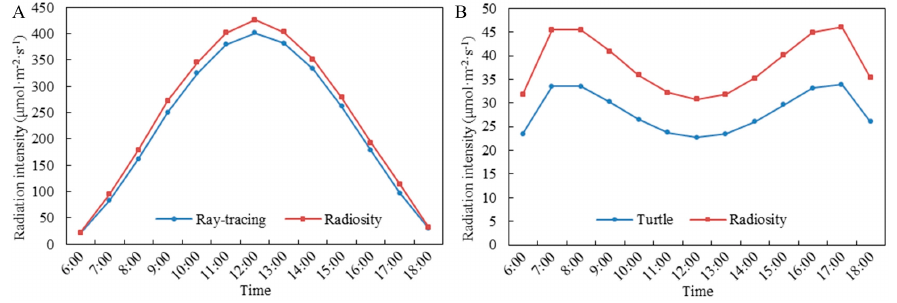
Figure 9. ( A ) Daily variation in the average hourly direct solar PAR intensity captured from the loquat, as simulated using radiosity and ray tracing; ( B ) The daily variation in the average hourly diffuse PAR intensity captured from loquat, as simulated using the radiosity and the TURTLE